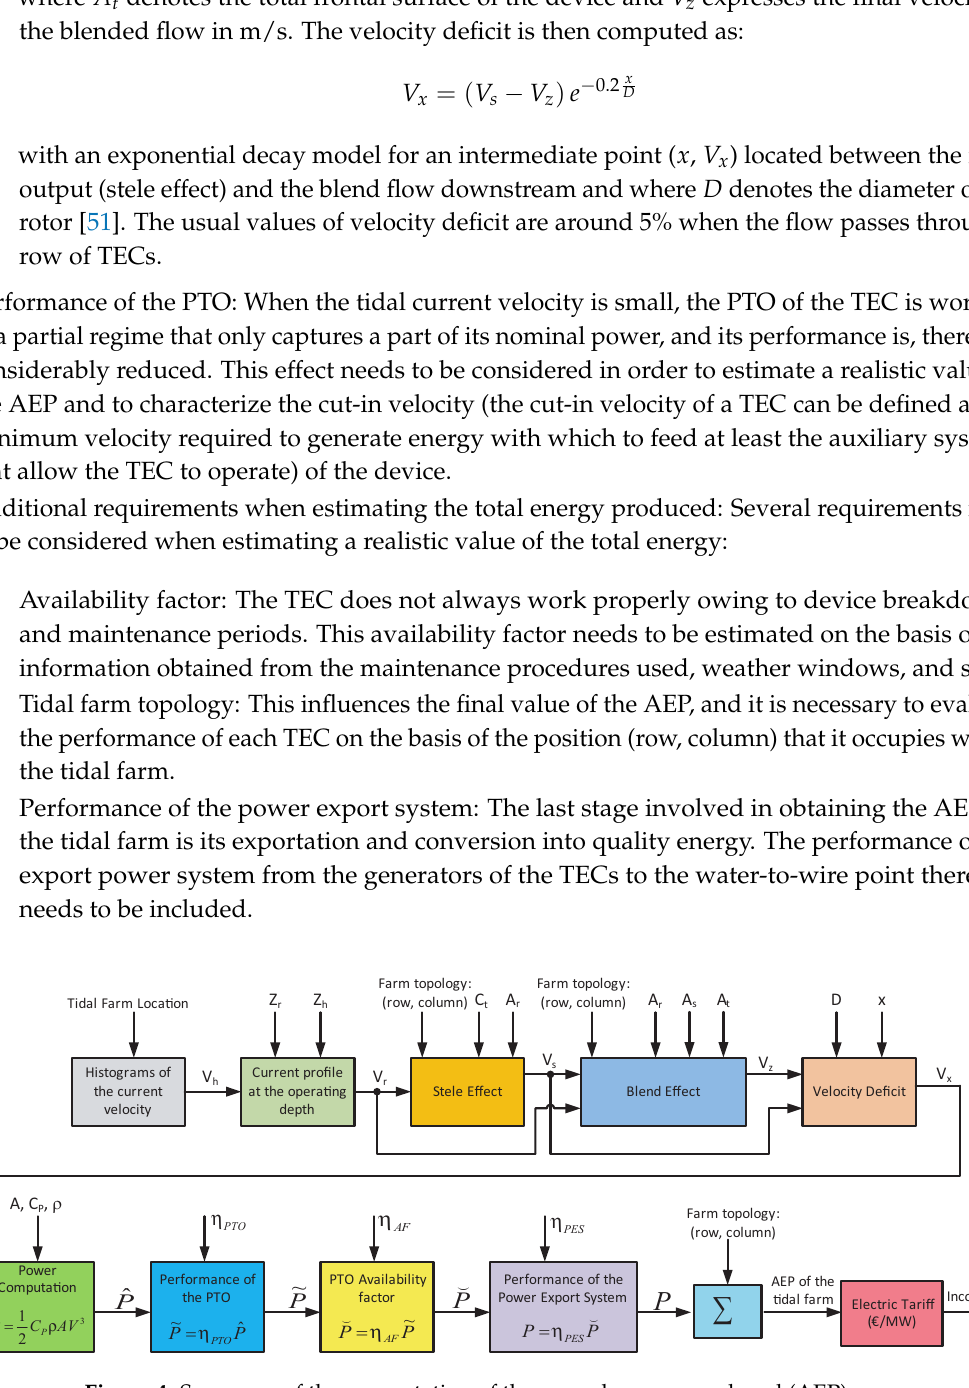
Figure 4. Summary of the computation of the annual energy produced